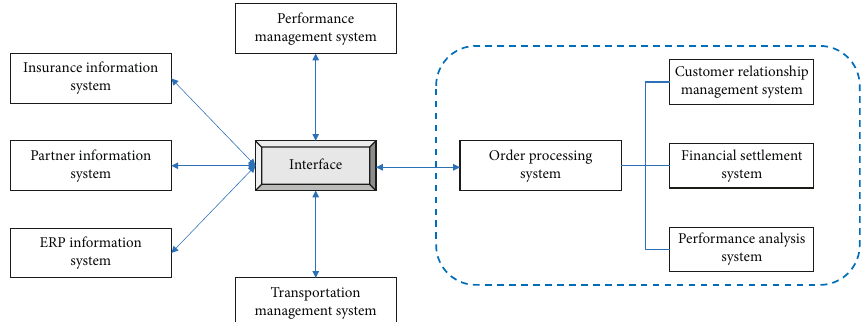
Figure 2: Function of industrial logistics information system.